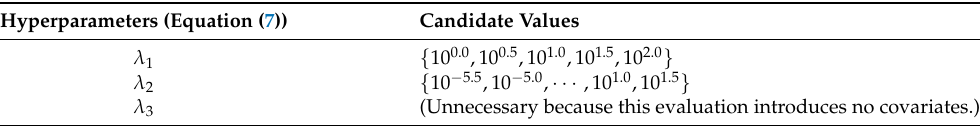
Table 2. Candidate hyperparameter values for Choi’s